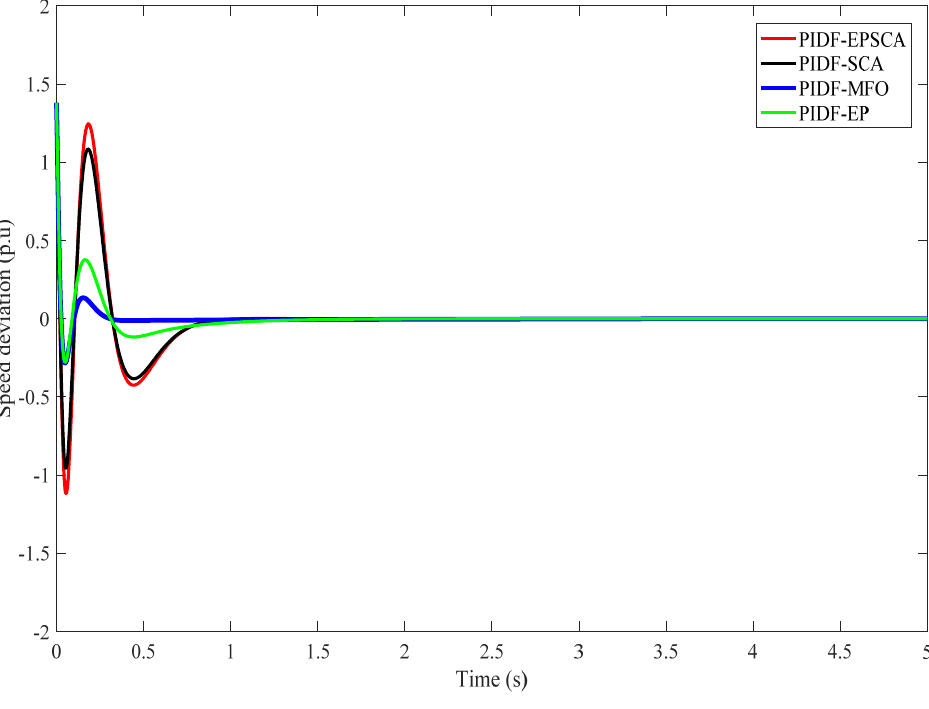
Figure 25. Speed deviation response of the TCSC-PIDF controller using PIDF-EPSCA, PIDF-SCA, PIDF-MFO, and PIDF-EP techniques for Scenario A-4.